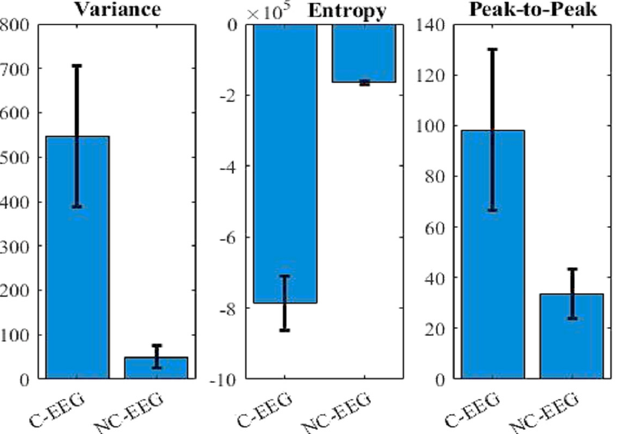
Figure 3. Comparison of the average value of features extracted from C − EEG and NC − EEG.